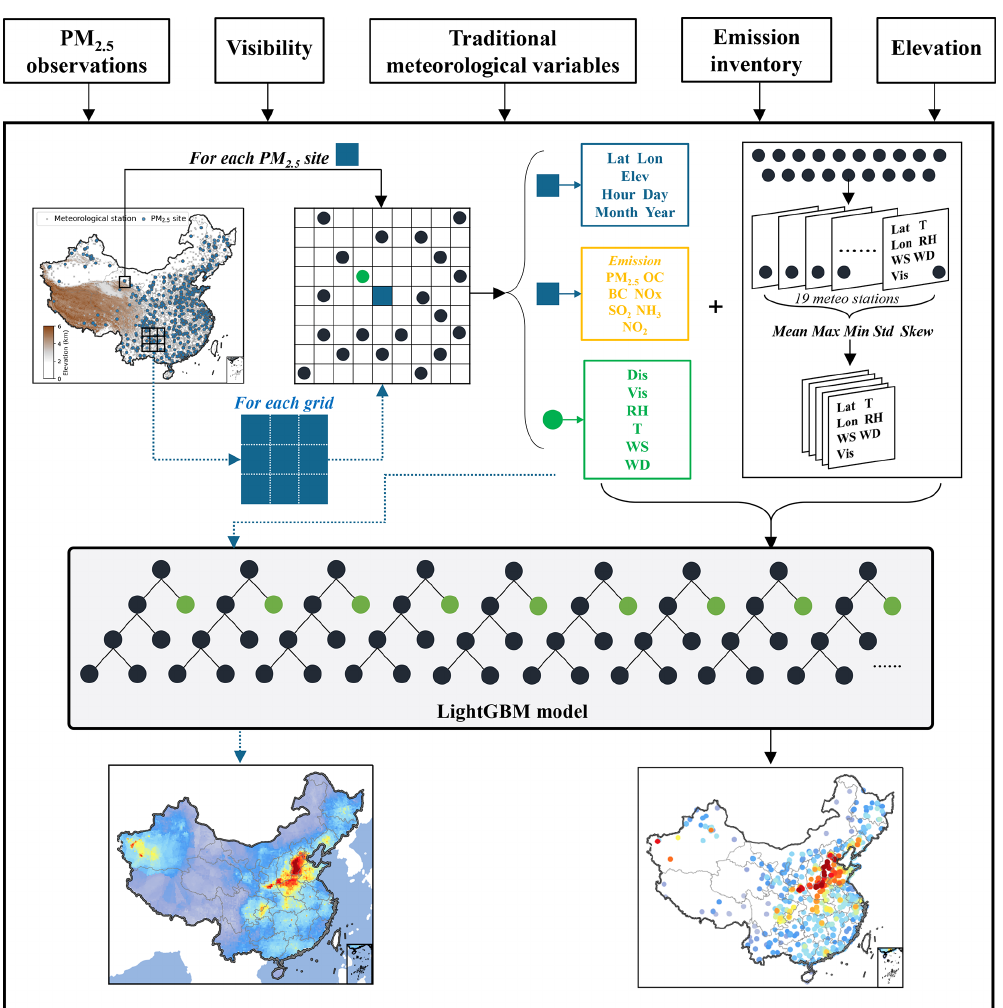
Figure 1. A conceptual scheme for constructing long-term historical site-based and gridded PM 2 . 5 records based on long-term visibility, conventional meteorological observations, emissions, and